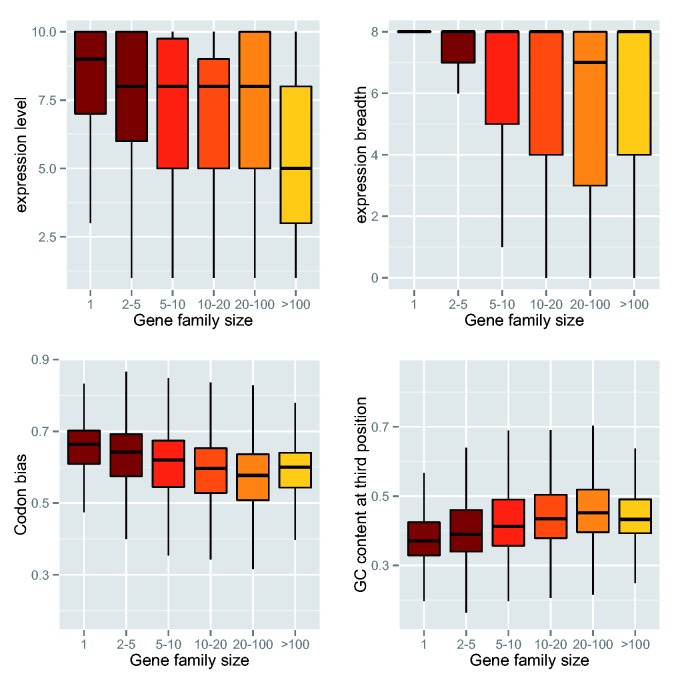
Gene family size showed significant associations with expression level, expression breadth, GC content at third position, and codon bias (Fop) in P. abies.